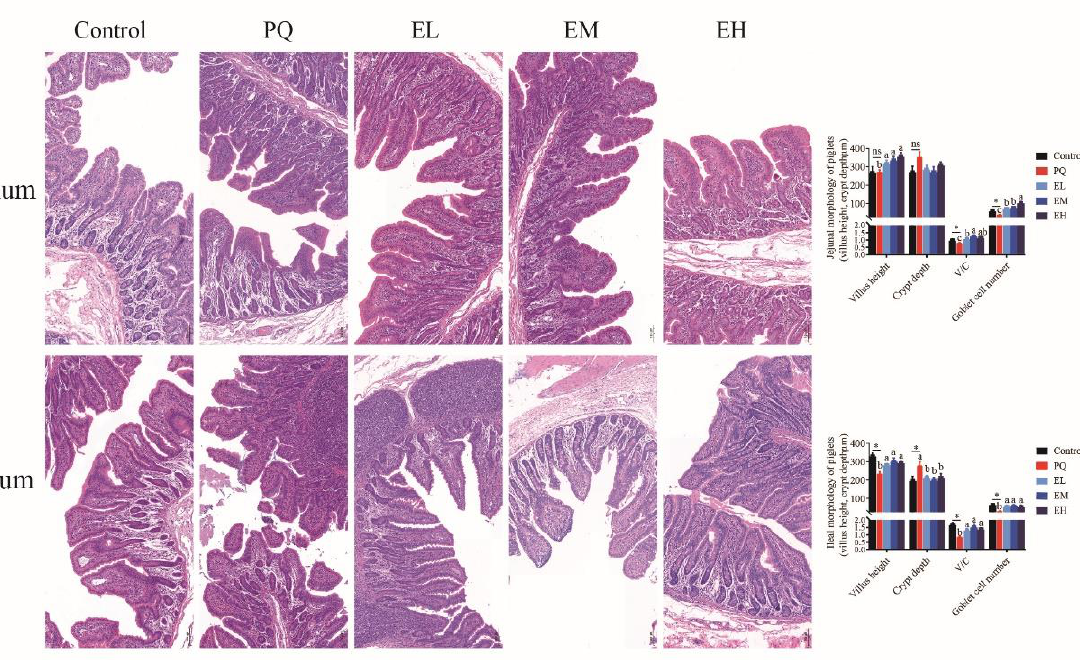
Figure 3. Intestinal mucosal morphology of piglets. ( A ) The histological representative images and histogram of morphological parameters of jejunal and ileal mucosa (magnification 200×). ( B ) Scanning electron microscopy analysis of jejunal and ileal mucosa (magnification 400×, 1000×). PQ = 4 mg/kg paraquet; EL = 0.005% ellagic acid + 4 mg/kg paraquet; EM = 0.01% ellagic acid + 4 mg/kg paraquet; EH = 0.02% ellagic acid + 4 mg/kg paraquet. n = 8. Data are shown as mean ± SEM. * means the difference was significant when compared to the control group. ns means the difference was not significant when compared to the control group. a – c Values with different lowercase letters are significantly different among PQ, EL, EM, and EH groups ( p < 0.05). 3.4. EA Supplementation Maintains the Structure of Tight Junction and Decreases the Permeability of Intestinal Barrier in PQ Challenged Piglets Because the tight junction plays a key role in maintaining the intestinal mucosal barrier integrity and the impermeability [39], we also evaluated the structure and protein abundances of tight junction (Figure 4A,B). Piglets in PQ group were observed to have shorter microvilli and a larger gap of enterocytes in jejunum and ileum as compared to the control group. Conversely, EA treatments displayed longer microvilli and restored intact tight junction protein structures in the jejunum and ileum (Figure 4A). Consistently, PQ significantly decreased the protein abundances of claudin-3 and occludin in jejunum and ileum as compared to control group ( p < 0.05), whereas EA treatments enhanced these protein expressions of in jejunum and ileum ( p < 0.05) (Figure 4B). Compared to the control group, PQ challenge increased DAO levels in serum ( p < 0.05). Compared to the PQ group, EM and EH groups significantly reduced serum DAO levels ( p < 0.05) (Figure 4C). These